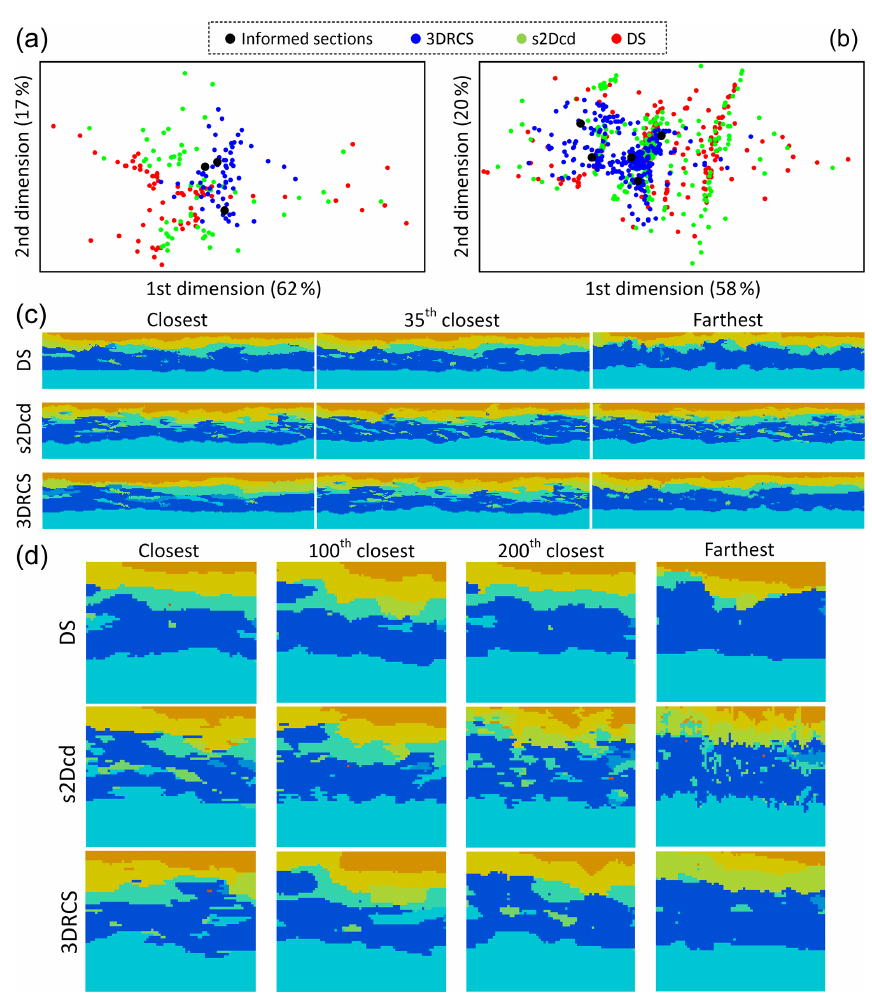
Figure 17. MDS maps of sections extracted from realizations using three different MPS approach. (a) MDS map of 70 sections for each realization along the xz direction; (b) MDS map of 280 sections for each realization along the yz direction; (c) selected sections for each method according to the JS divergence in the xz direction; (d) selected sections in the yz